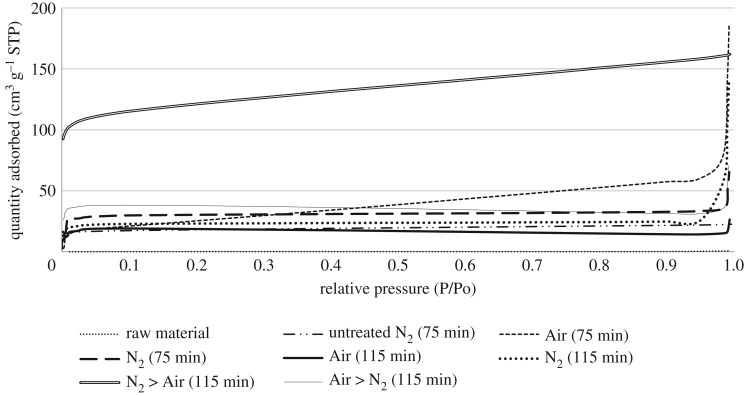
N2-Adsorption isotherm for the sample at 77 K for PKS bioadsorbent.